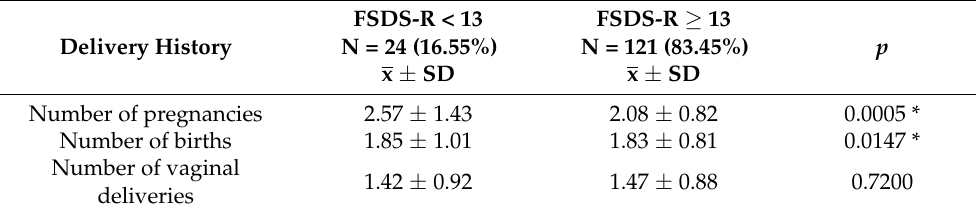
Table 5. Analysis of the influence of delivery history on the level of satisfaction with sexual life, according to the FSDS-R scale (N =